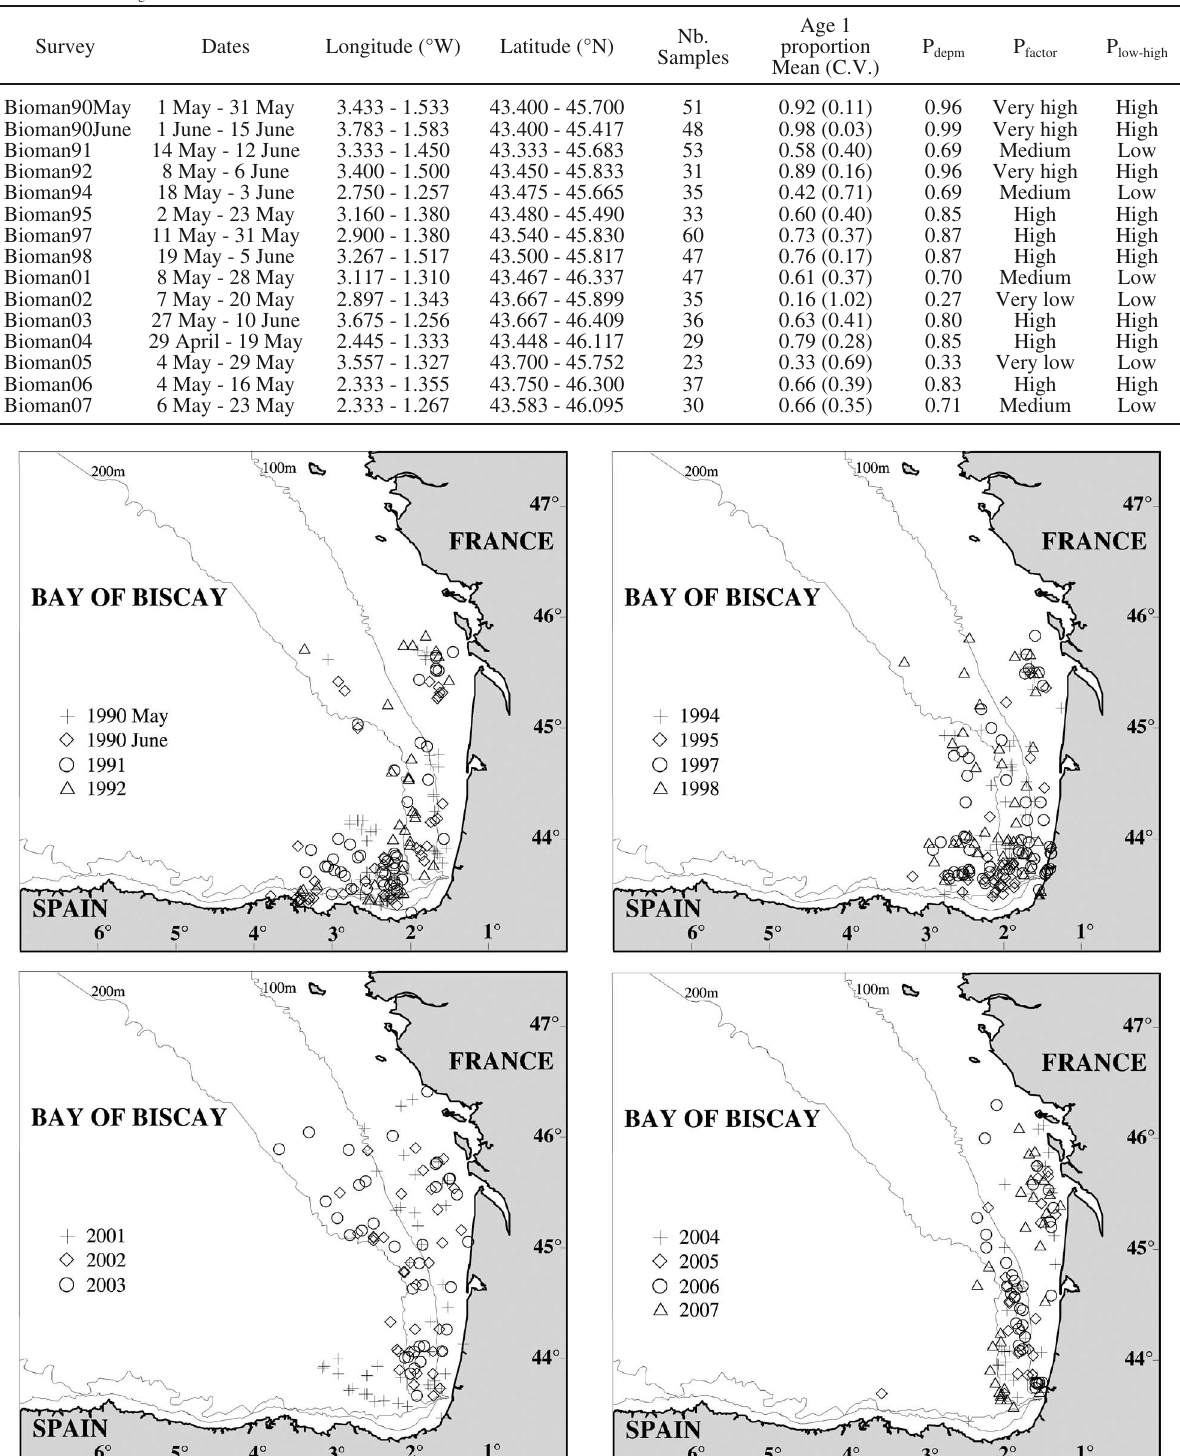
Table 1. – Summary of the Bay of Biscay daily egg production method (DEPM) adult surveys from 1990 to 2007. The age-1 proportion corresponds to the average proportion of all the samples per survey. P , overall age-1 proportion estimated from the DEPM surveys; P depm a factor of five classes (very low, low, medium, high and very high) indicating the overall age-1 proportion as derived from the stock assess- ment; P , a factor of two classes (low and high) indicating the overall age-1 proportion as derived from the stock assessment. low-high